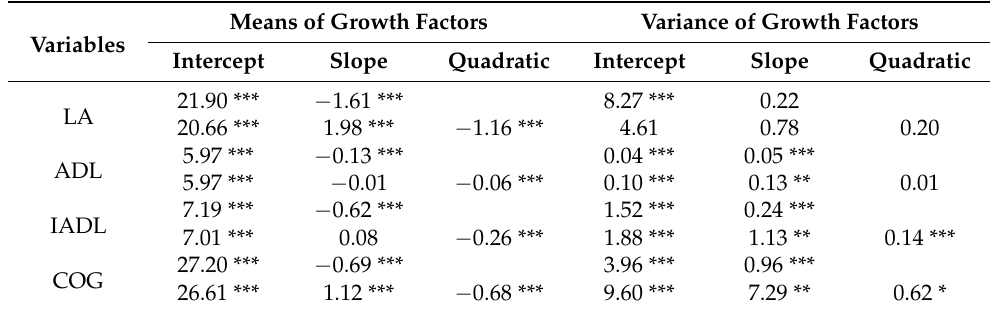
Table 3. Model parameter values.